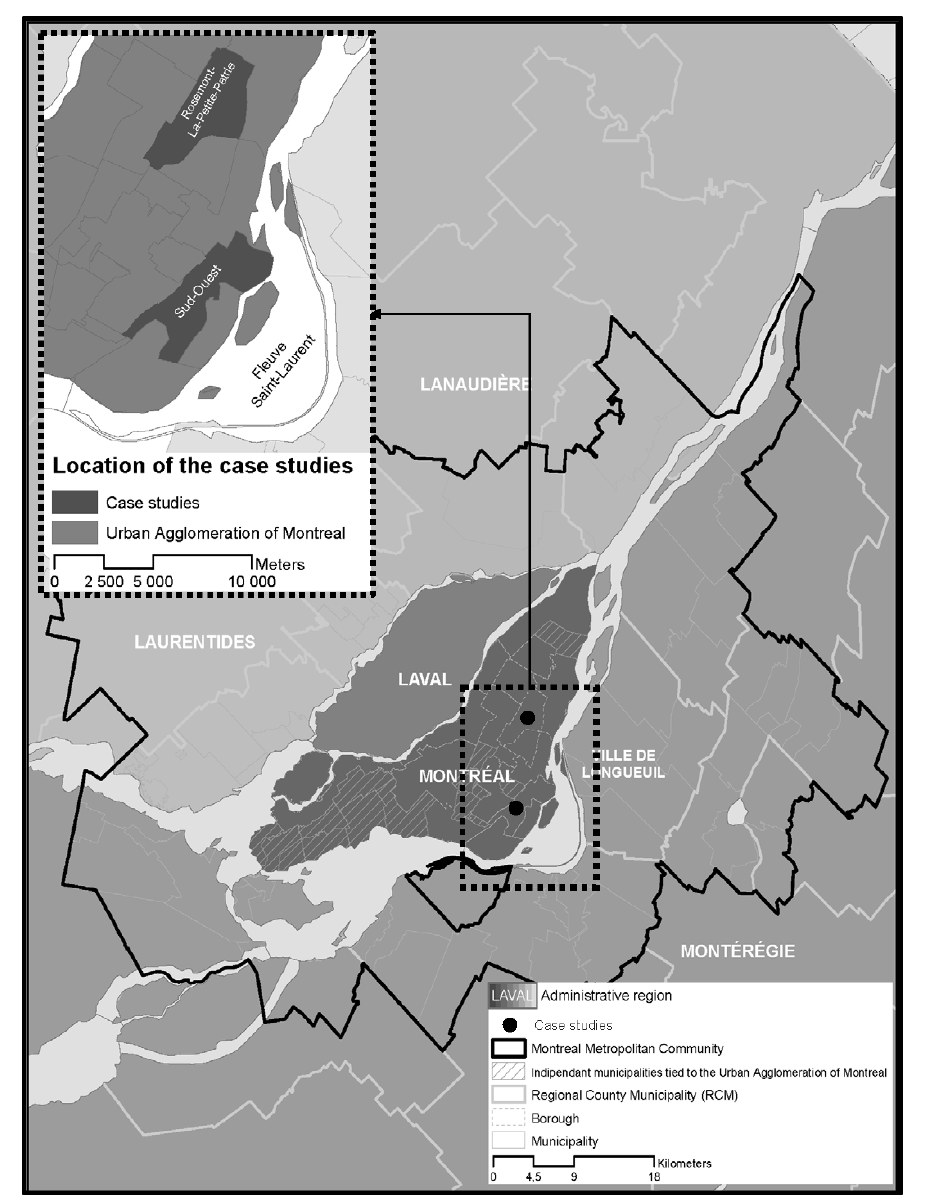
Figure 1. Case studies in Montreal. Source: own production. Rosemont, for its part, experienced strong industrial growth in the early 20th century due to the presence of the Canadian Pacific Railway company and Ateliers Angus (established by Canadian Pacific Railway), which manu- factured locomotives and railroad cars (Nadeau, 2009). The industrialization of these neighborhoods thus ex- plains the strong presence of a working class—and also explains their disarray 5 during the crisis of Fordism and the industrial redeployment of the